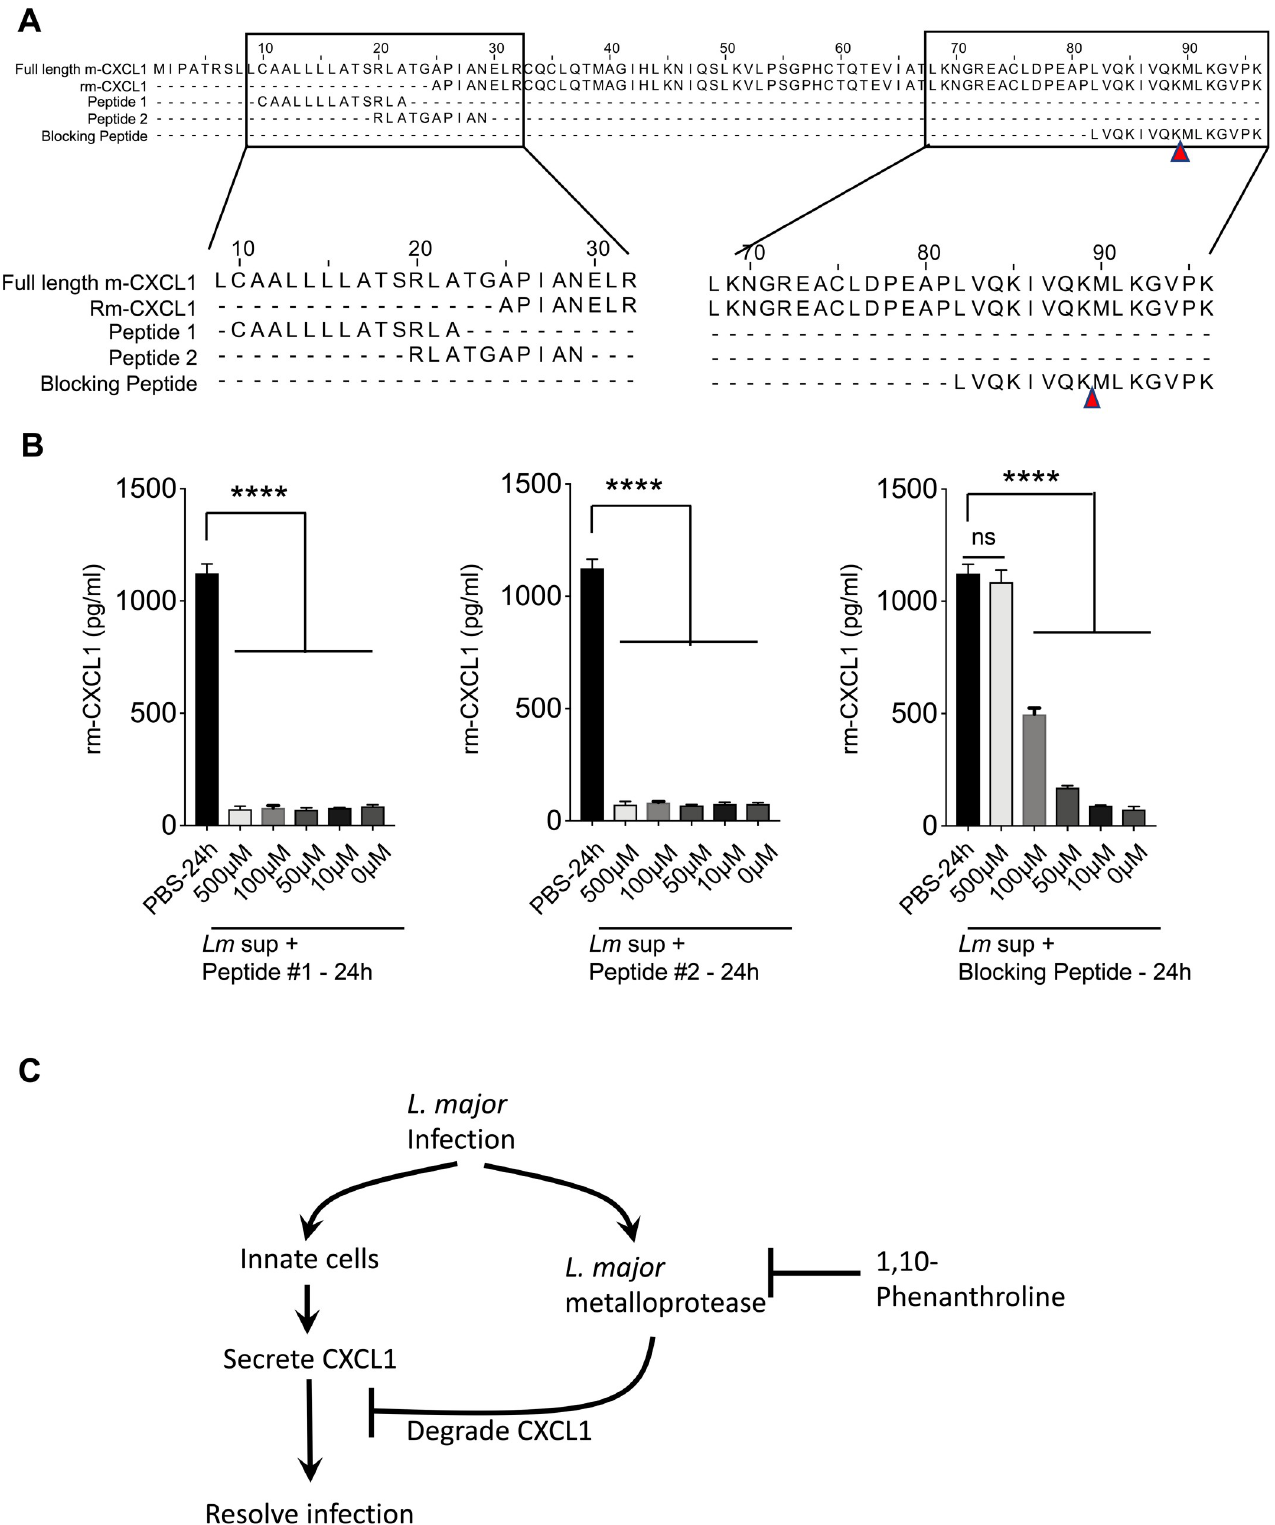
Fig 7. Synthetic peptide spanning rm-CXCL1 cleavage site inhibits L . major -mediated CXCL1 degradation. (A) Schematic of synthetic peptide generation. Alignment of full length murine CXCL1 with mature murine CXCL1 demonstrating the schematic for generation of peptide#1, peptide#2 and blocking